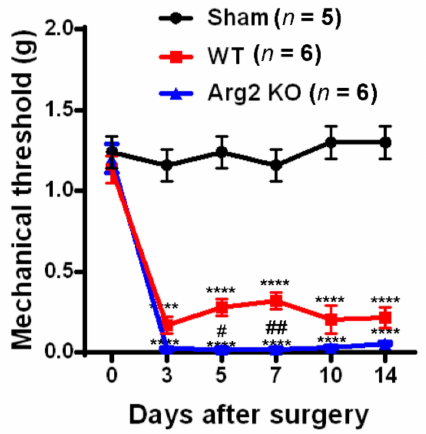
Figure 1. Pain behavioral tests of mice after surgery: The von Frey filament test. Von Frey filament tests were performed repeatedly on days 3, 5, 7, 10, and 14 post-surgery in the sham ( n = 5), wild-type (WT; n = 6), and arginase 2 (Arg2) knockout (KO; n = 6) groups of mice. Following spinal nerve transection (SNT) surgery, the pain thresholds of the WT group decreased compared to the sham group. The lowest pain threshold was observed in the Arg2 KO group. Data are presented as means ± standard error of the mean (SEM) (two-way analysis of variance (ANOVA) with Tukey’s post hoc test, F (10,82) = 13.30, **** p < 0.0001 versus Sham; ( n = 6), ## p < 0.01, and # p < 0.05 versus WT ( n =